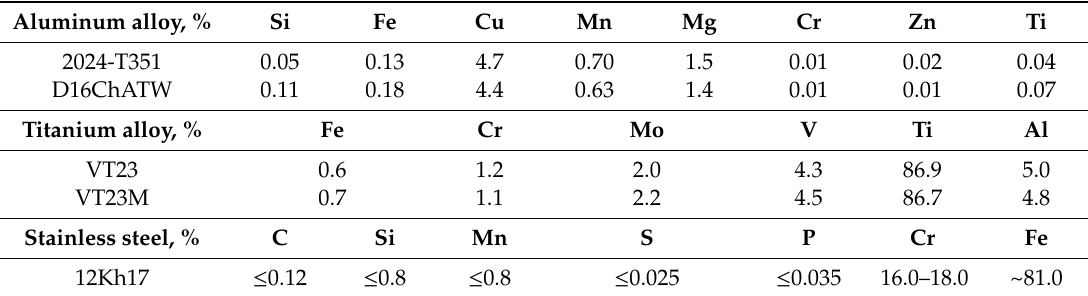
Table 2. Chemical composition of materials